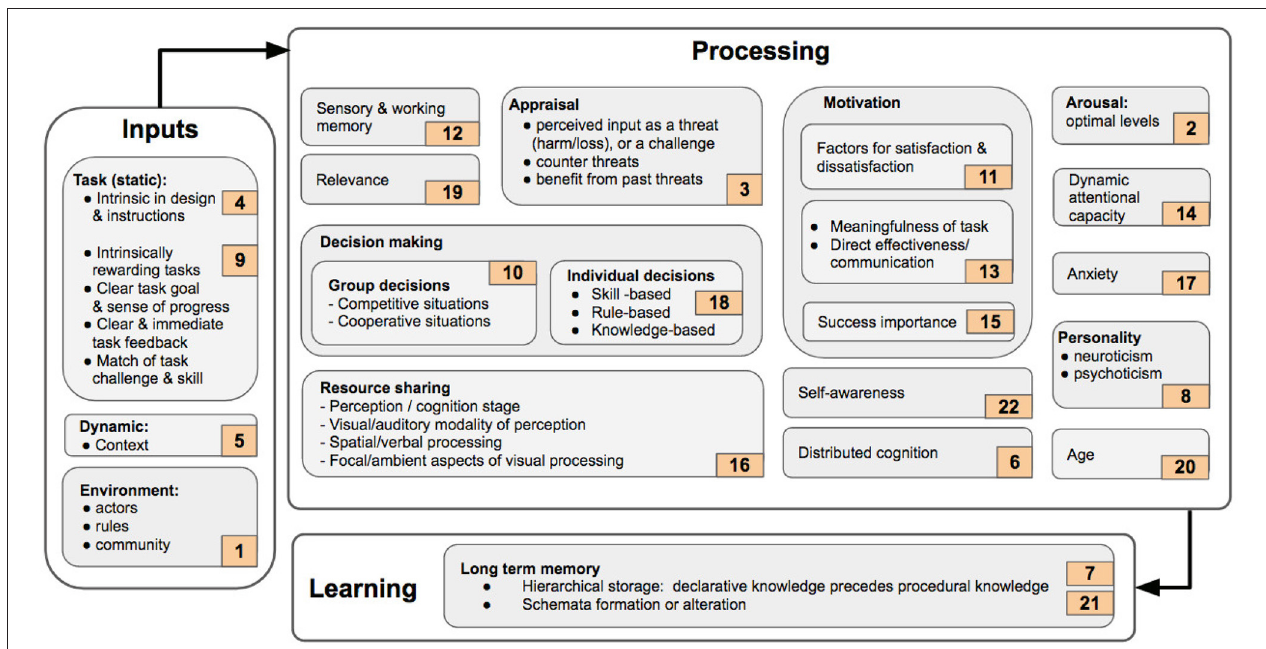
FIGURE 8 | Theories linked to the construct of mental workload organized as a